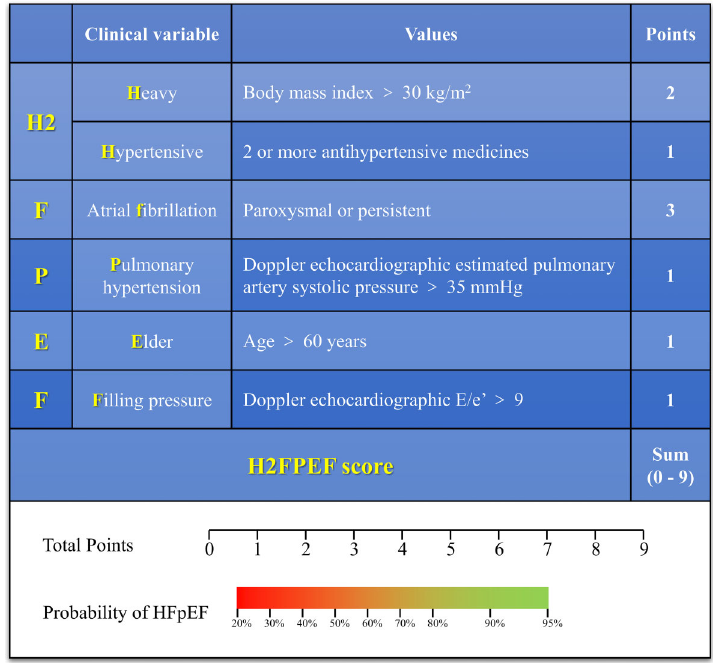
Figure 1. Description of the H2FPEF score and point allocations for each clinical characteristic (top), with associated probability of having heart failure with preserved ejection fraction (HFpEF) based on the total score as estimated from the model (bottom).